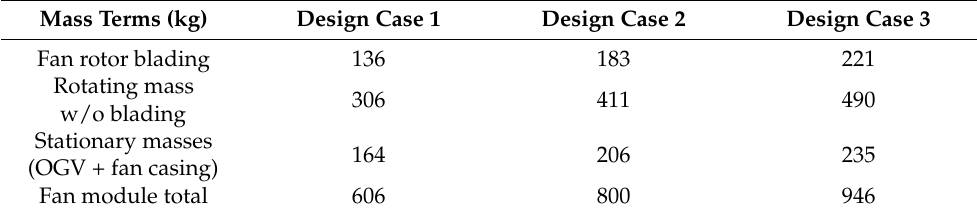
Table 5. FF component masses predicted for the CENTRELINE Rev 07 design